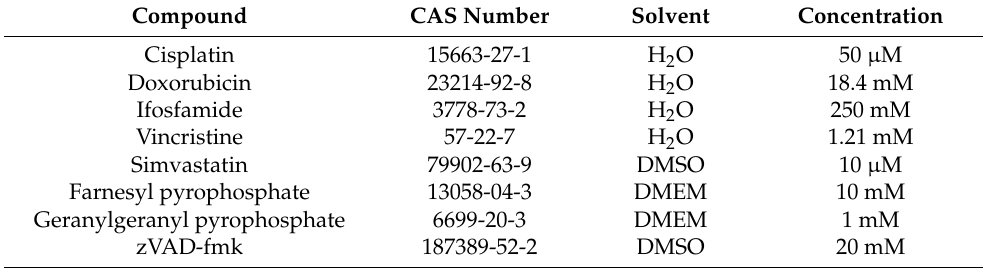
Table 1. Details of stock